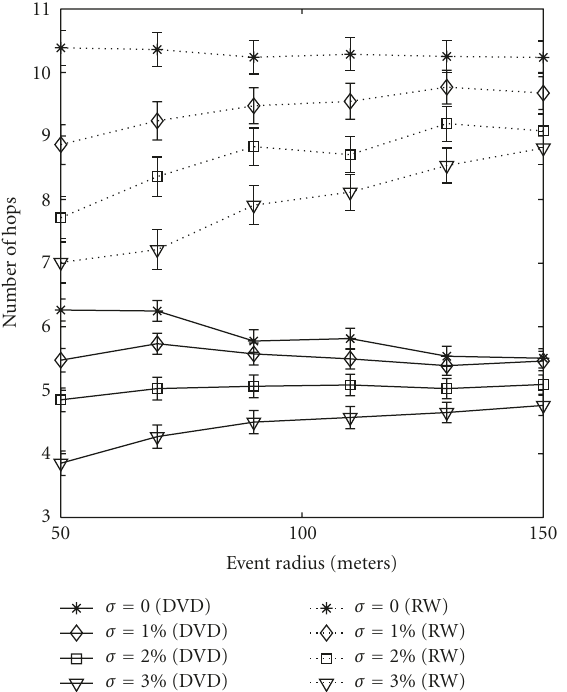
Figure 23: Sensitivity of end-to-end delay for DVD and